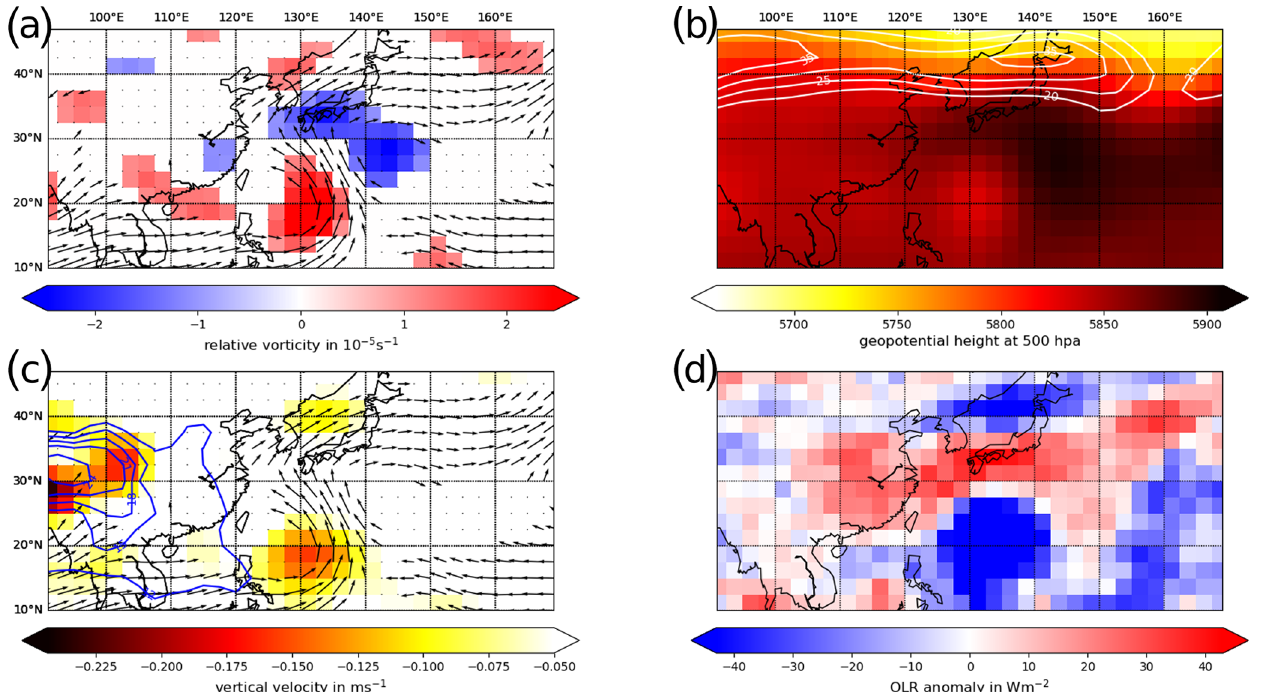
Figure 10. Composites based on the dates with strong inter-band activity (see Fig. 6c and Table 1). (a) Average 850hPa winds with speed larger than 5ms − 1 and relative vorticity larger than 10 − 5 s − 1 (red tones) and smaller than − 10 − 5 s − 1 (blue tones). (b) Average 500hPa geopotential height (shaded) and 200 hPa wind speed larger than 20ms − 1 (white contours). (c) Average 850hPa winds with speed larger than 5ms − 1 , specific humidity larger than 12gkg − 1 (blue contour, interval 3gkg − 1 ) and 700hPa updraft vertical velocity larger than 0 . 05Pas − 1 (shaded). (d) OLR anomalies with respect to the NOAA long-term mean between